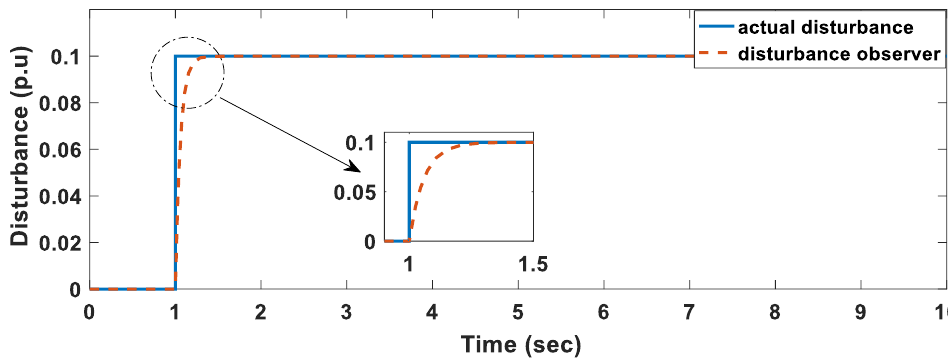
Figure 7. Estimated and actual disturbance for scenario 3.